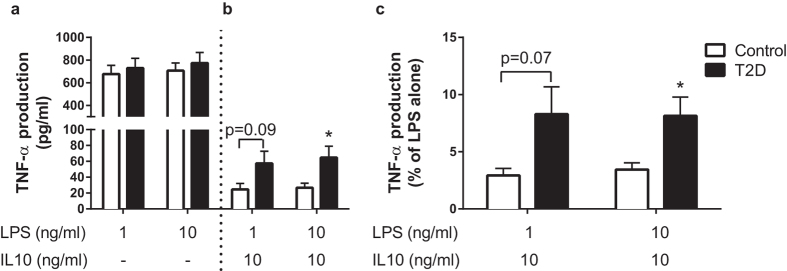
Humans with T2D display hyporesponsiveness to IL10.Whole blood cultures were stimulated with LPS only (1 and 10 ng/ml) or LPS + IL10 (10 ng/ml) and pro-inflammatory activation was assessed by TNF-α secretion. A two-way ANOVA revealed no significant differences in (a) LPS-induced TNF-α secretion between T2D patients (n = 24) and age and BMI-matched non-T2D controls (n = 22) at both 1 ng/ml and 10 ng/ml LPS. However, the ability of IL10 to suppress TNF-α secretion was less effective in T2D (main effect of group, P < 0.05) for both absolute (b) and % maximal (c) TNF-α secretion with post-hoc tests revealing a significant difference at 10 ng/ml LPS combined with 10 ng/ml IL10 (P < 0.05 for both). Biological replicates were cultured and TNF-α secretion measured by standard ELISA. IL10 inhibition is expressed as % maximal TNF-α secretion within each subject calculated as ([(LPS-induced secretion–LPS + IL10 secretion)/LPS secretion] × 100%). Values are mean ± SEM, *P < 0.05 vs. Control.